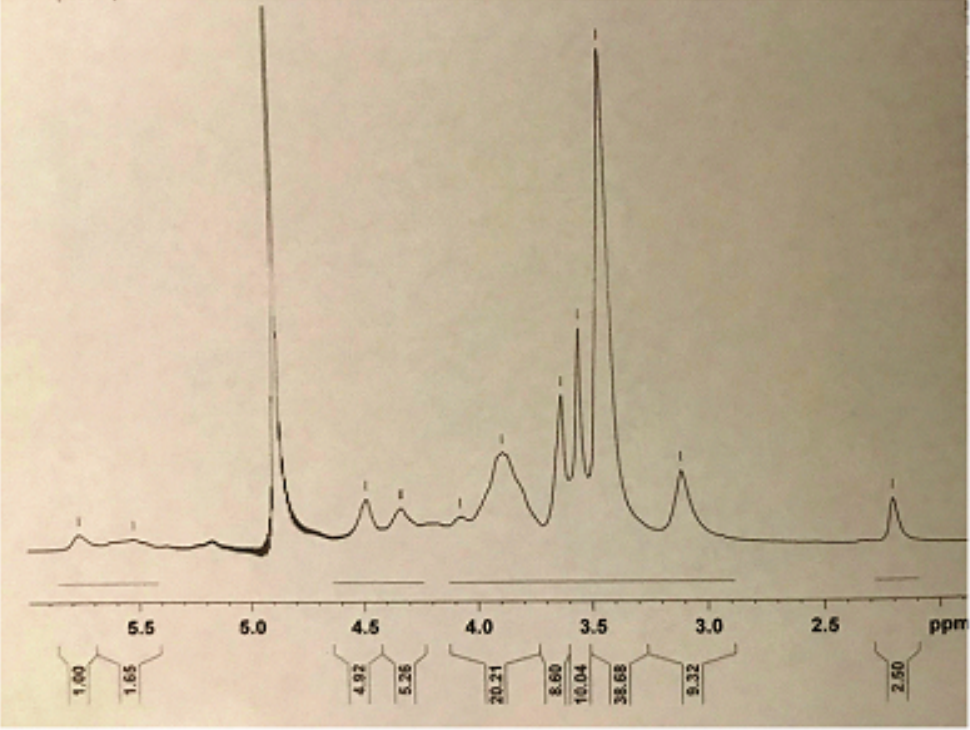
Figure 1. FT-IR spectra of Cs, TMC, and TCs.